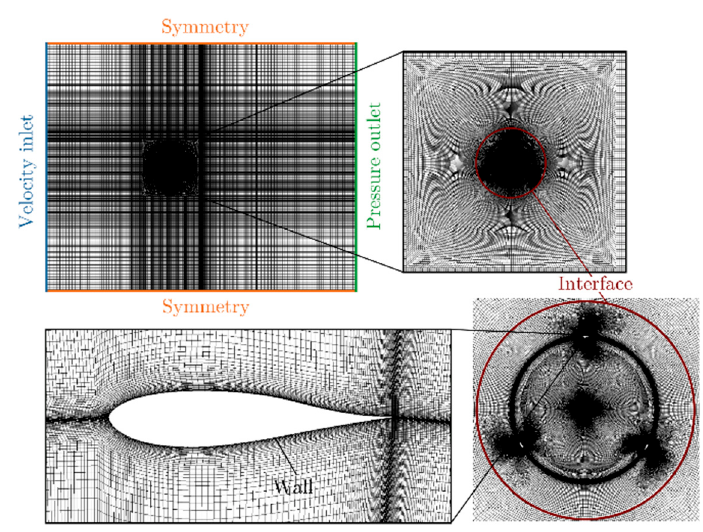
Figure 2. Simulation domain, mesh and boundary conditions.